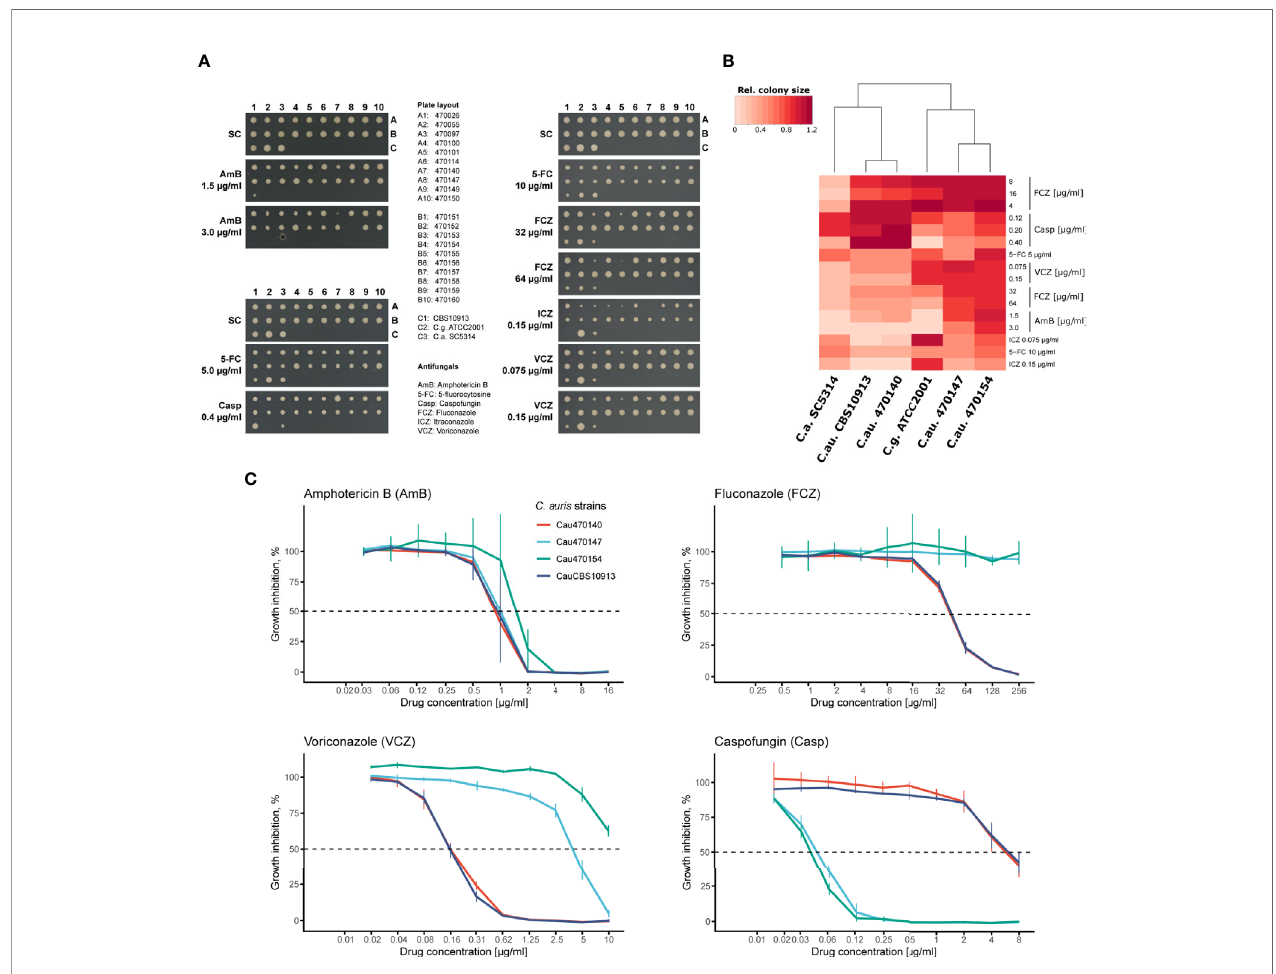
FIGURE 1 | C. auris clinical isolates show variations in antifungal susceptibility. (A) Plate-based drug susceptibilities of clade-I C. auris clinical isolates. Overnight cultures in YPD medium were spotted on synthetic complete medium plates containing the indicated antifungals. Plates were imaged after 3 days incubation at 30°C. (B) Heatmap of screening results shown in A for the indicated strains. Colony sizes were quanti fi ed and normalized to control plates. Color codes indicate the relative colony size for the corresponding condition and represents the mean of two screening plates. (C) Con fi rmation of plate-based screening results using liquid growth inhibition assays. Cells were incubated in YPD medium with the indicated antifungal drugs at 30°C for 24 hours prior to OD 600 measurement. Data represent mean +/- SD from 3 biological replicates.